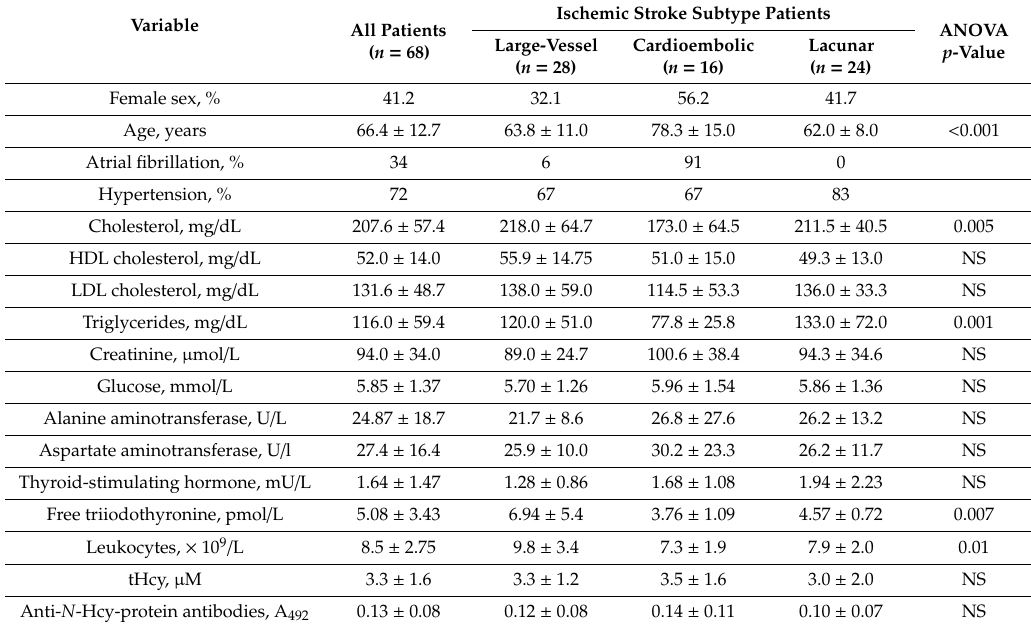
Table 2. Characteristics of ischemic stroke patients.